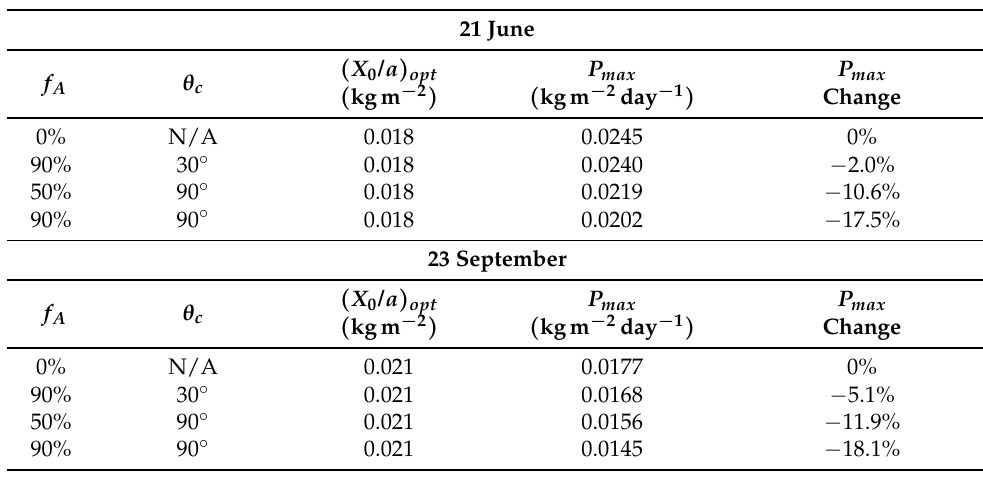
Table 2. Maximum biomass productivity P max and the corresponding optimum optical thickness ( X ) opt for each window condition on 21 June and 23 September. The percent change in P max 0 / a compared to that of a dry window ( f A = 0%) is also